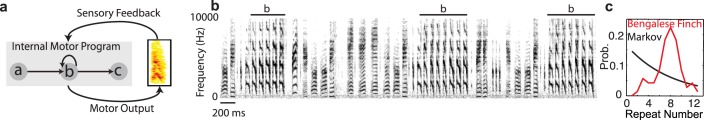
Bengalese finch song and the generation of sequences.a: Diagram of sensory-motor circuit for sequence generation. An internal motor program generates transitions between actions (‘a’, ‘b’, ‘c’, etc) while sensory feedback from the actions (motor outputs) impinges on the motor program. b: Example of Bengalese finch song. Spectrogram (power at frequency vs. time) of an adult Bengalese finch song, which consists of several syllables (denoted with letters) produced in probabilistic sequences. A prominent feature of Bengalese finch songs is the presence of syllable repetitions, some with long repeat sequences (e.g. syllable ‘b’). c: Probability distribution of repeat counts for syllable ‘b’ from an individual Bengalese finch (red), and the predicted probability distribution for a Markov process using first order transition probabilities.